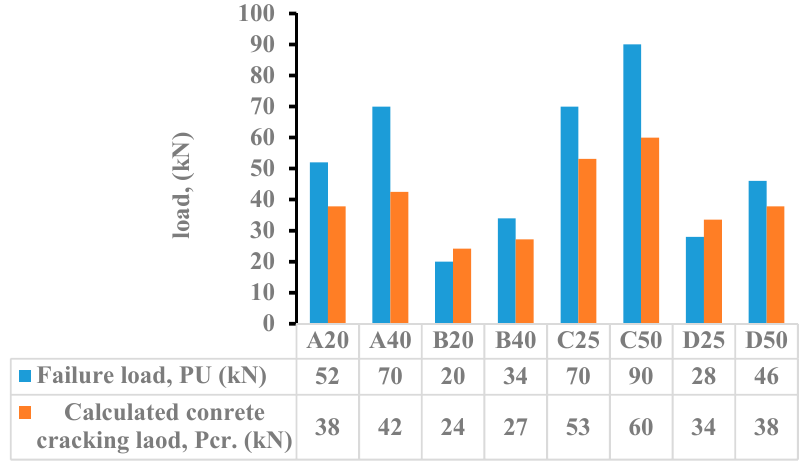
Figure 15. Experimental failure load (P U ) versus the calculated cracking load (P cr .).